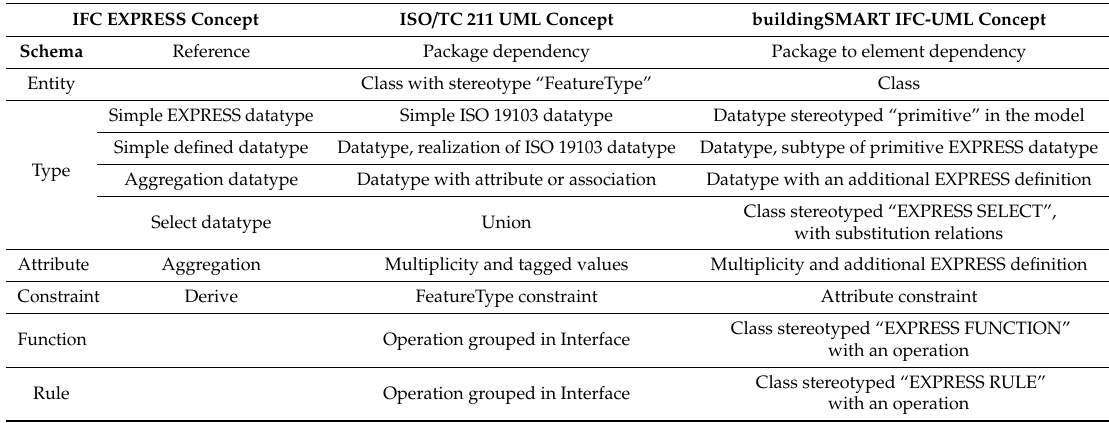
Table 4. Comparison of UML models.